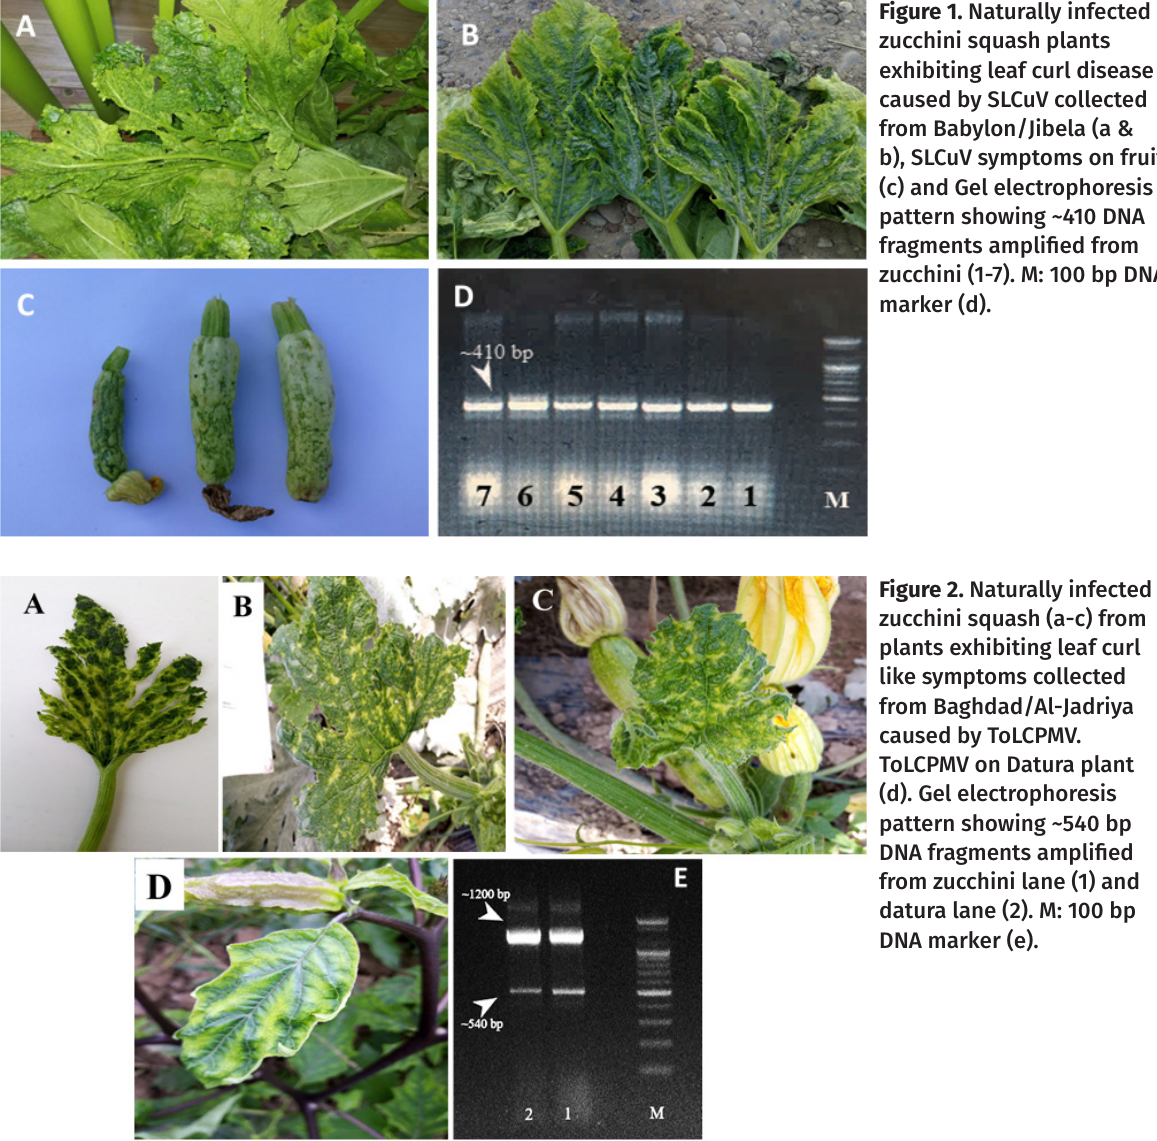
Figure 1. Naturally infected zucchini squash plants exhibiting leaf curl disease caused by SLCuV collected from Babylon/Jibela (a & b), SLCuV symptoms on fruit (c) and Gel electrophoresis pattern showing ~410 DNA fragments amplified from zucchini (1-7). M: 100 bp DNA marker (d).